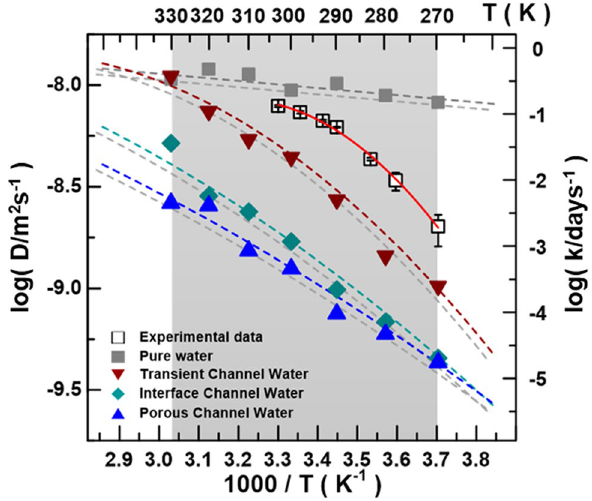
Figure 6. The temperature-dependent diffusion constant D of the pure water of the MD simulation box (gray square), the transient channel water (inverted red triangle), the interface channel water (green diamond), and the porous channel water (blue triangle) in the PFK-1 tetramer structure, respectively. The D unit is presented on the left vertical axis in the logarithmic unit, and the respiration rates k obtained from the experiment are plotted with the black hollow squares for comparison; the unit is given on the right vertical axis and the gray region is the temperature range of the MD simulation.